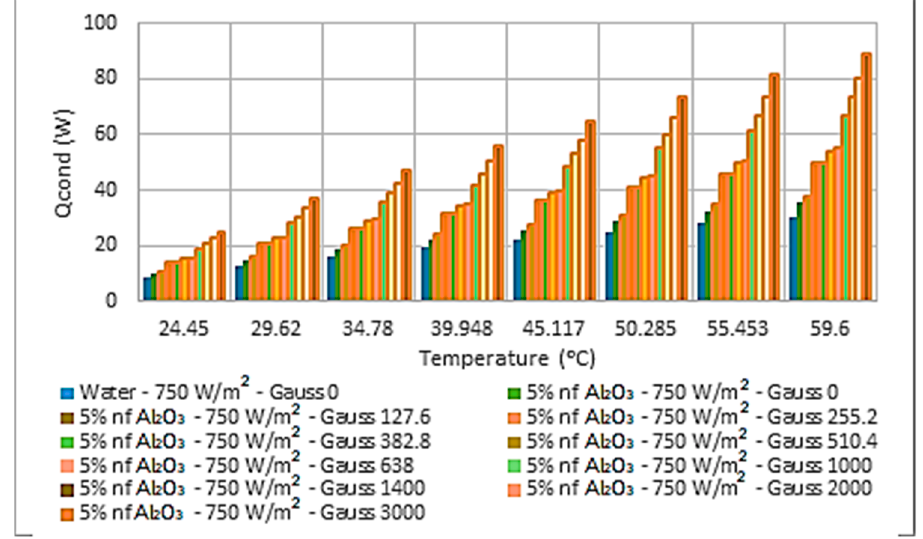
Figure 6. Thermal energy at heat pipe condenser generated by PV-Th solar panels.